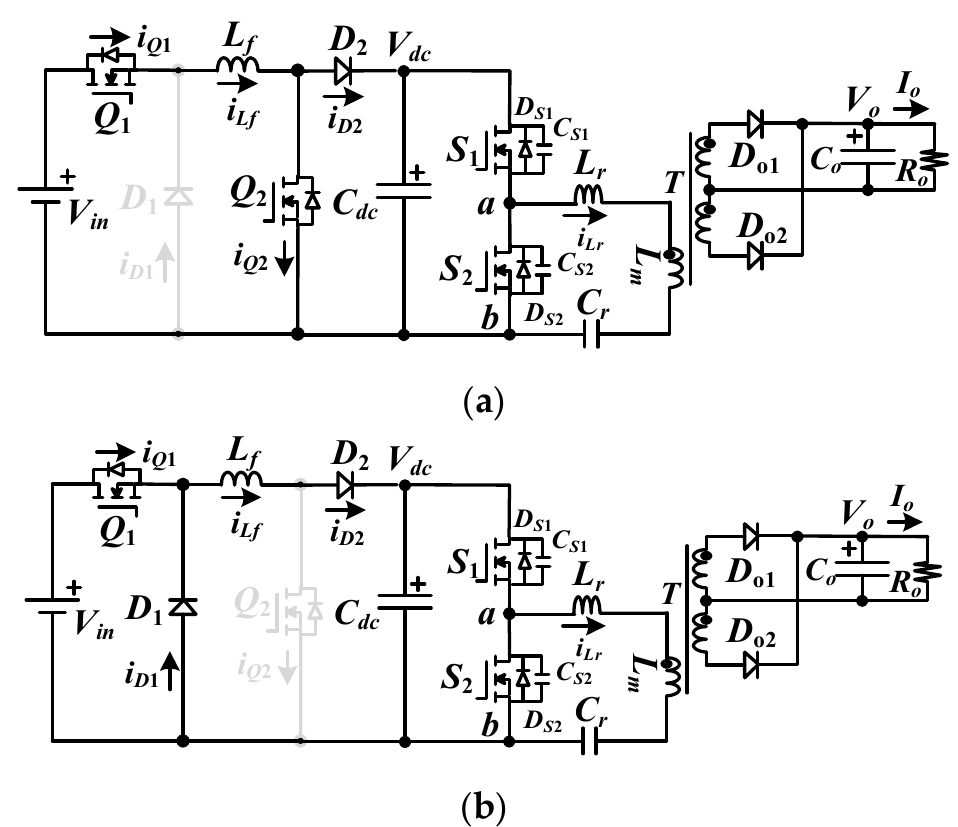
Figure 2. Equivalent circuits for ( a ) low input voltage operation ( b ) high input voltage operation.